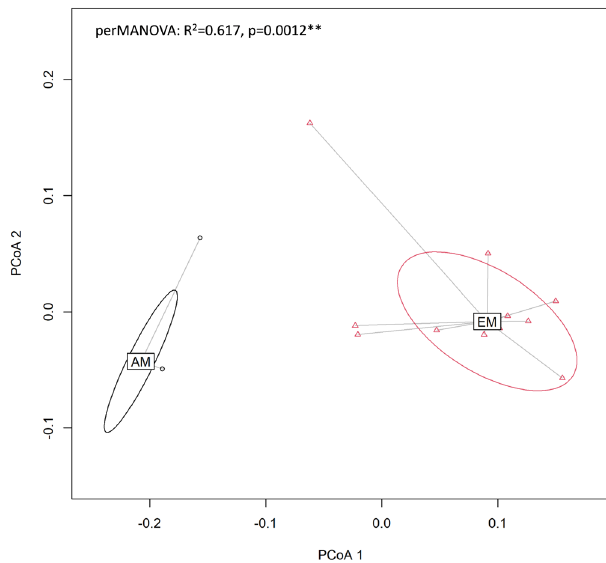
Fig. 2 Principal coordinate analysis of mycelium chemistry. Clustering and centroids of AM and EM mycorrhizal fungal species in a multidimensional space of